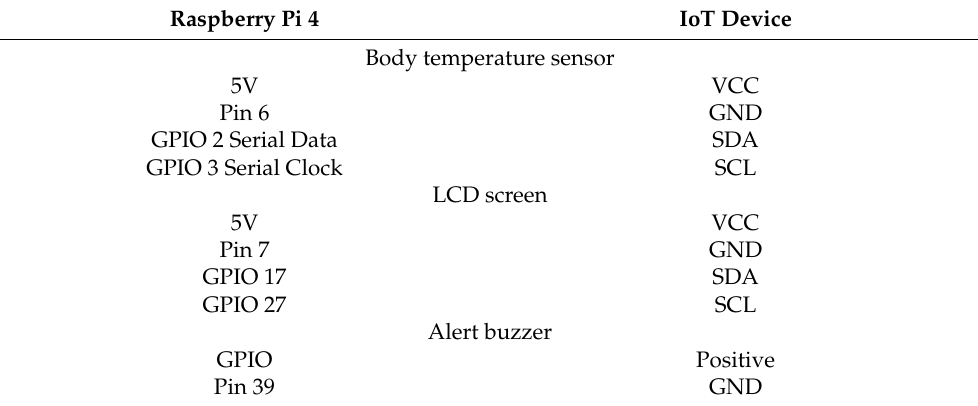
Table A1. Pin connections of Raspberry Pi 4.